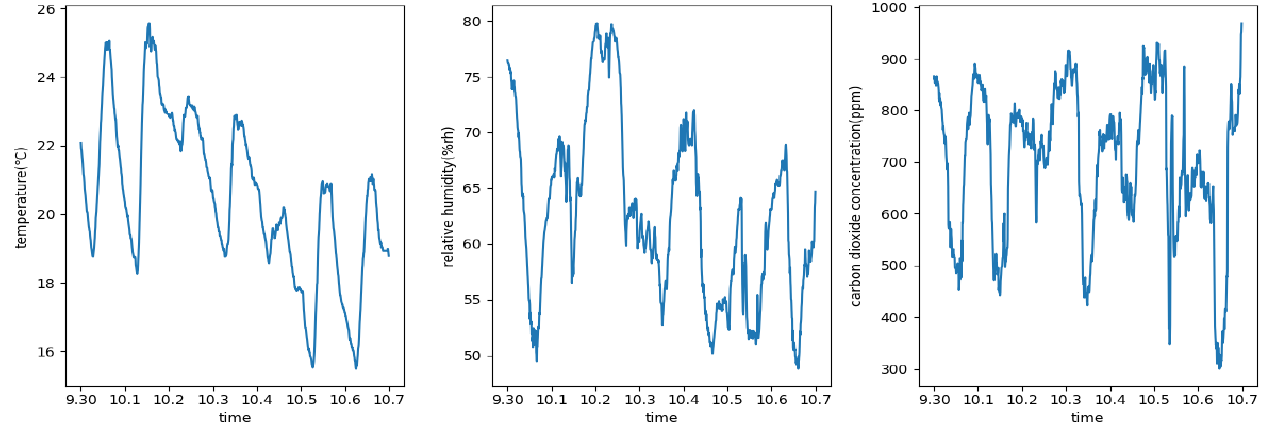
Figure 6. Rabbit house environmental variables within a week.